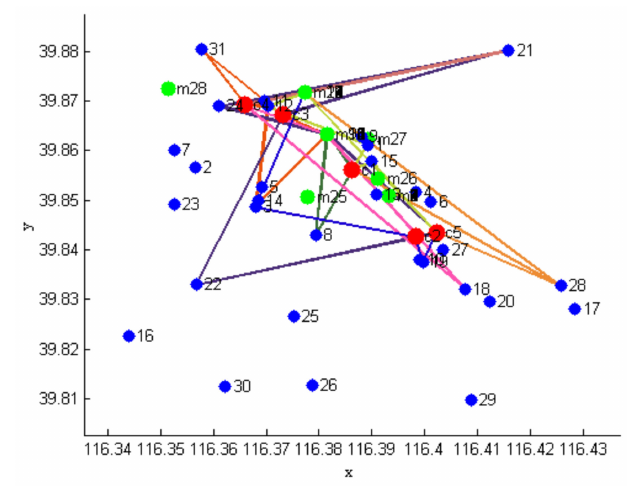
Figure 14. Distribution routes of deliverymen 15–21.